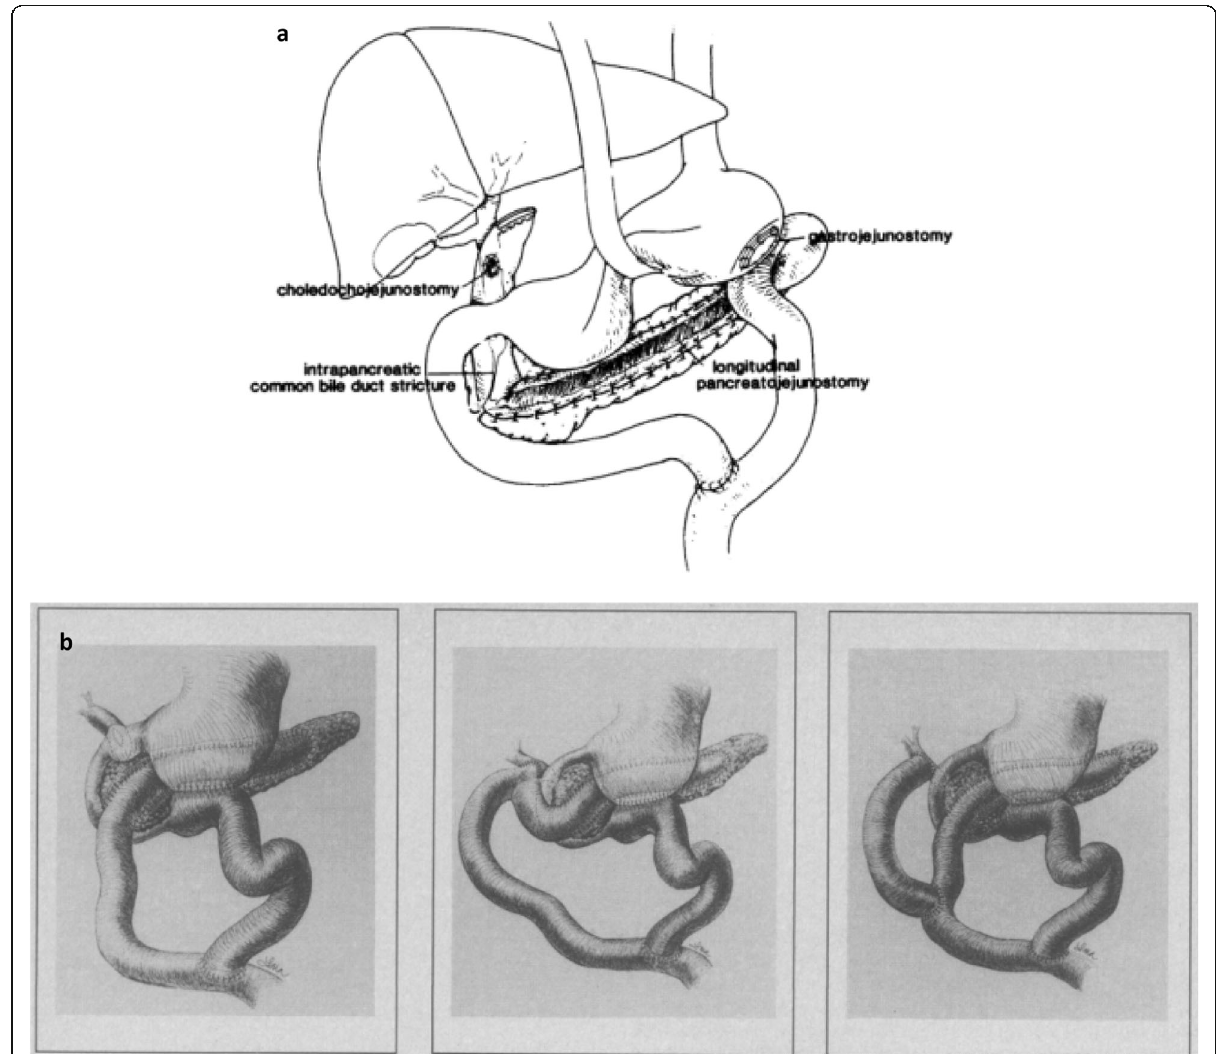
Fig. 7 Harvey et al. [12] reported a surgical procedure with combined biliary, pancreatic, and gastric drainage ( a ). Richard et al. [13] reported three methods of treating combined obstructive complications ( b ). Permission to reproduce both figures was obtained from